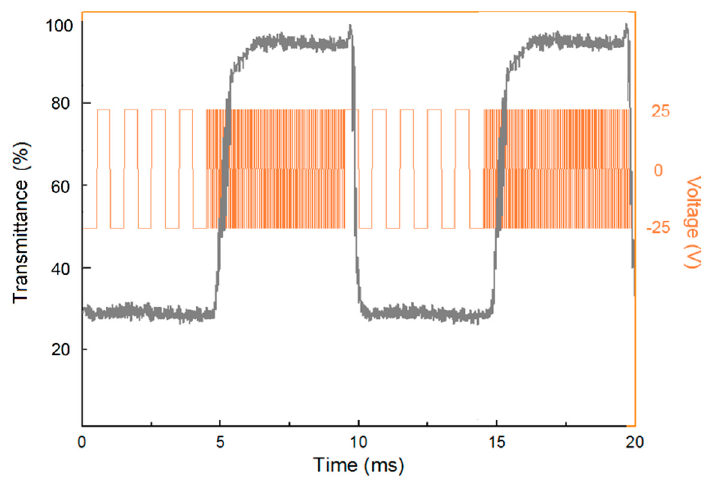
Figure 5 . The switching response of the sample (gray line) to the applied signals (orange line).